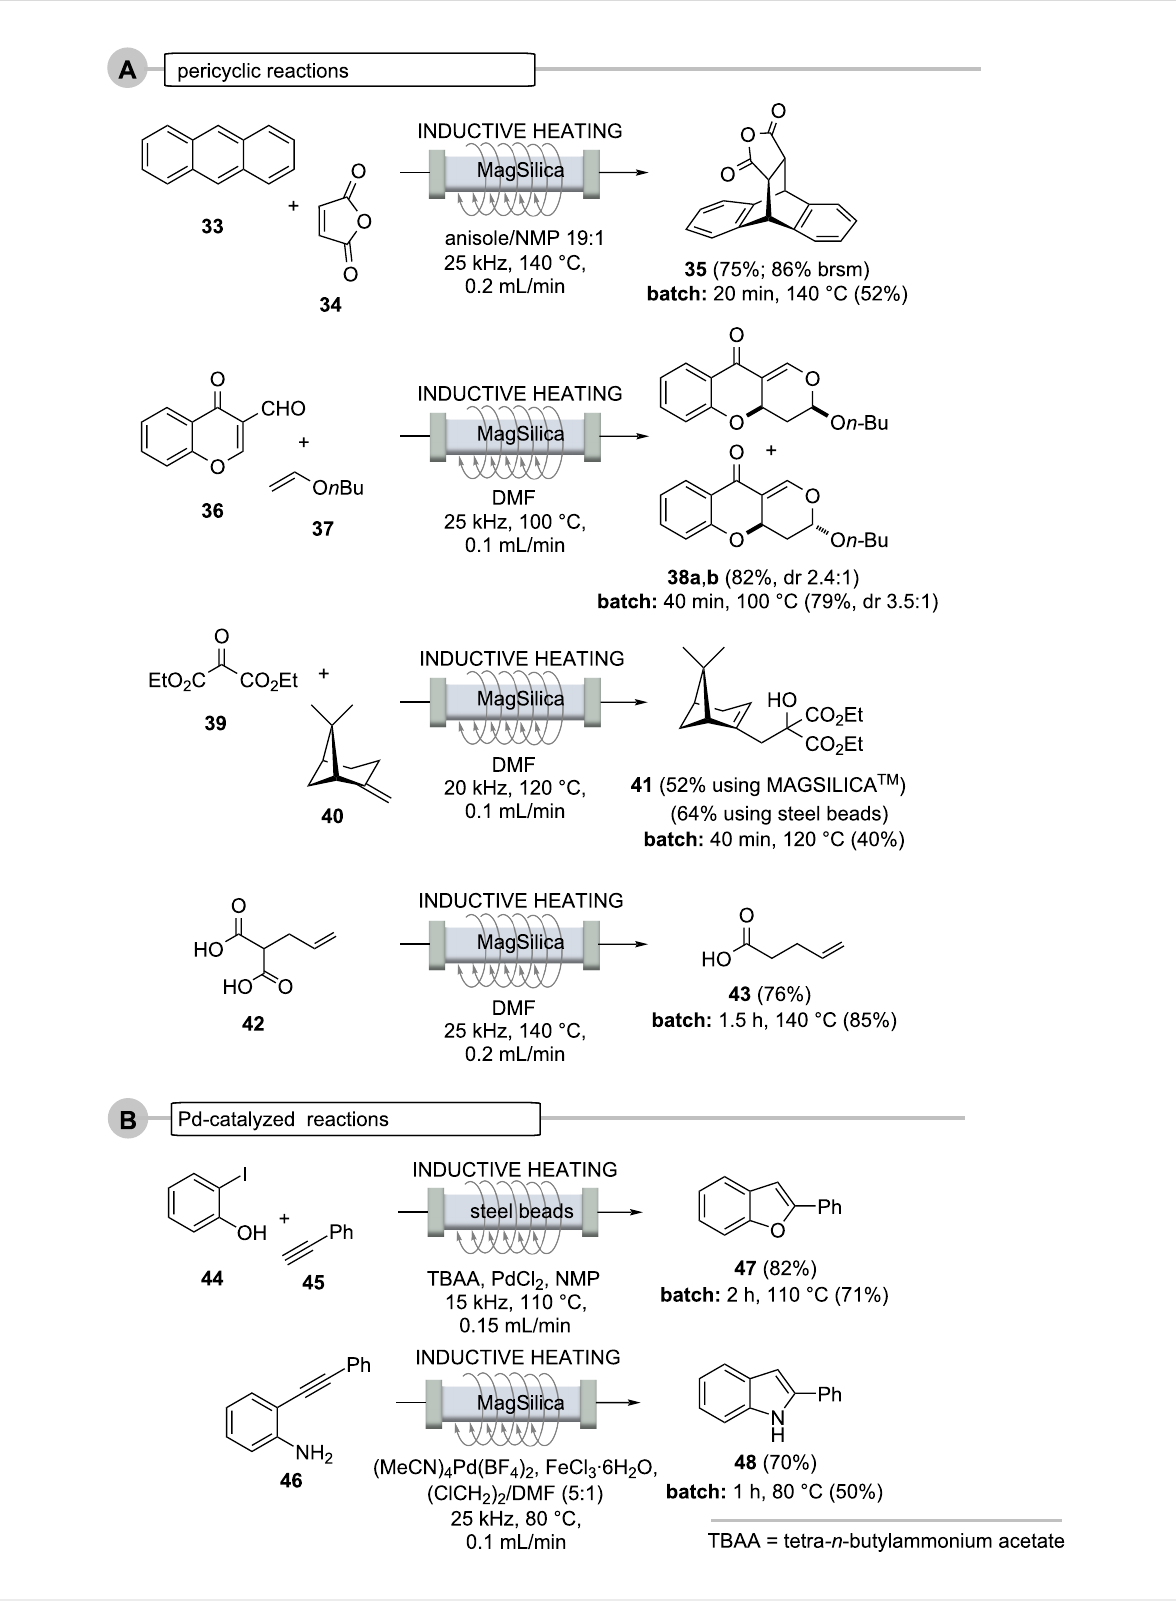
Scheme 10: Continuous flow reactions and comparison with batch reaction (oil bath). A. pericyclic reactions and B. Pd-catalyzed